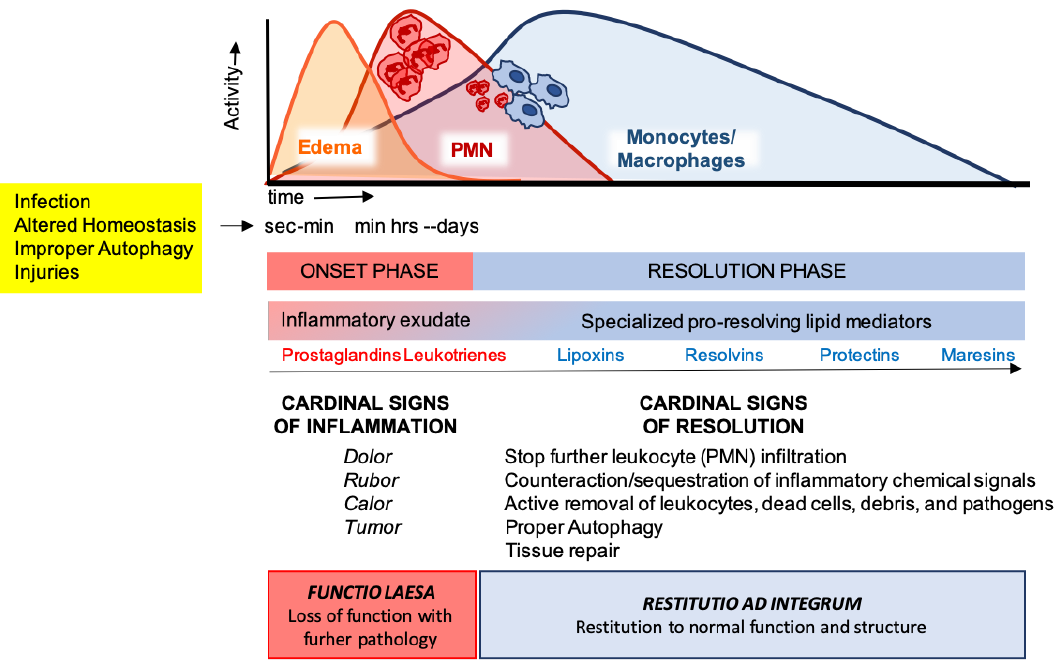
Figure 2. The acute inflammatory response and its ideal outcome: essential steps, mechanisms, and definitions. Injury, infections, or dysregulated homeostasis ignite the acute inflammatory response that is normally a host protective mechanism. The first event in acute inflammation is edema formation, followed by infiltration of polymorphonuclear leukocytes (PMNs), and then monocyte and macrophages that clear PMNs leading to resolution, which is essential for ensuring host protection and sparing from tissue damage.